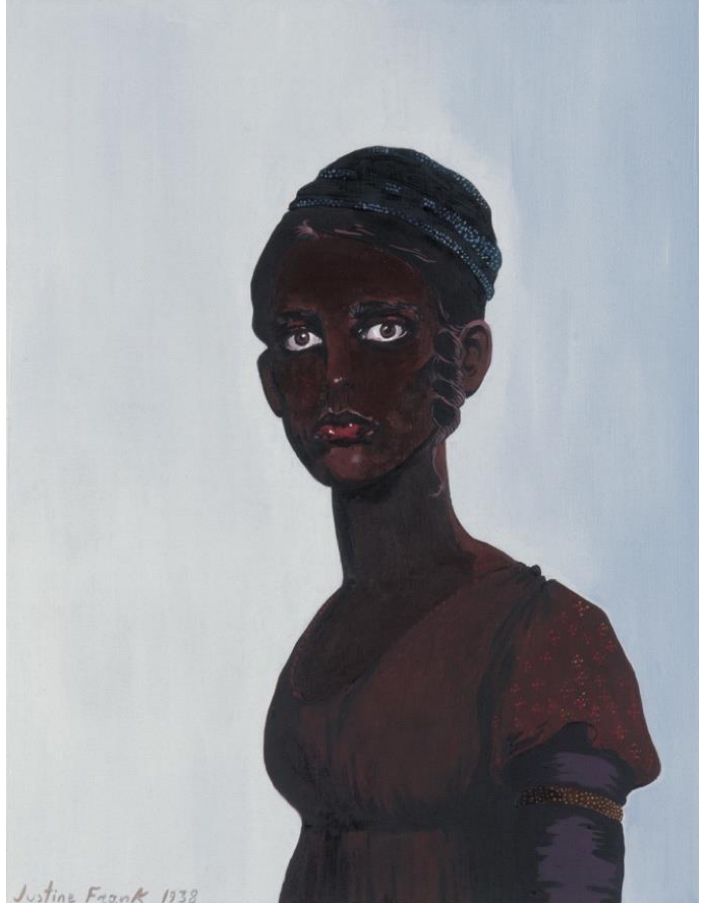
Figure 22. Justine Frank, Untitled (Self Portrait as a Black Woman) , 1938, oil on canvas, 65 × 50 cm. Courtesy of the artist.